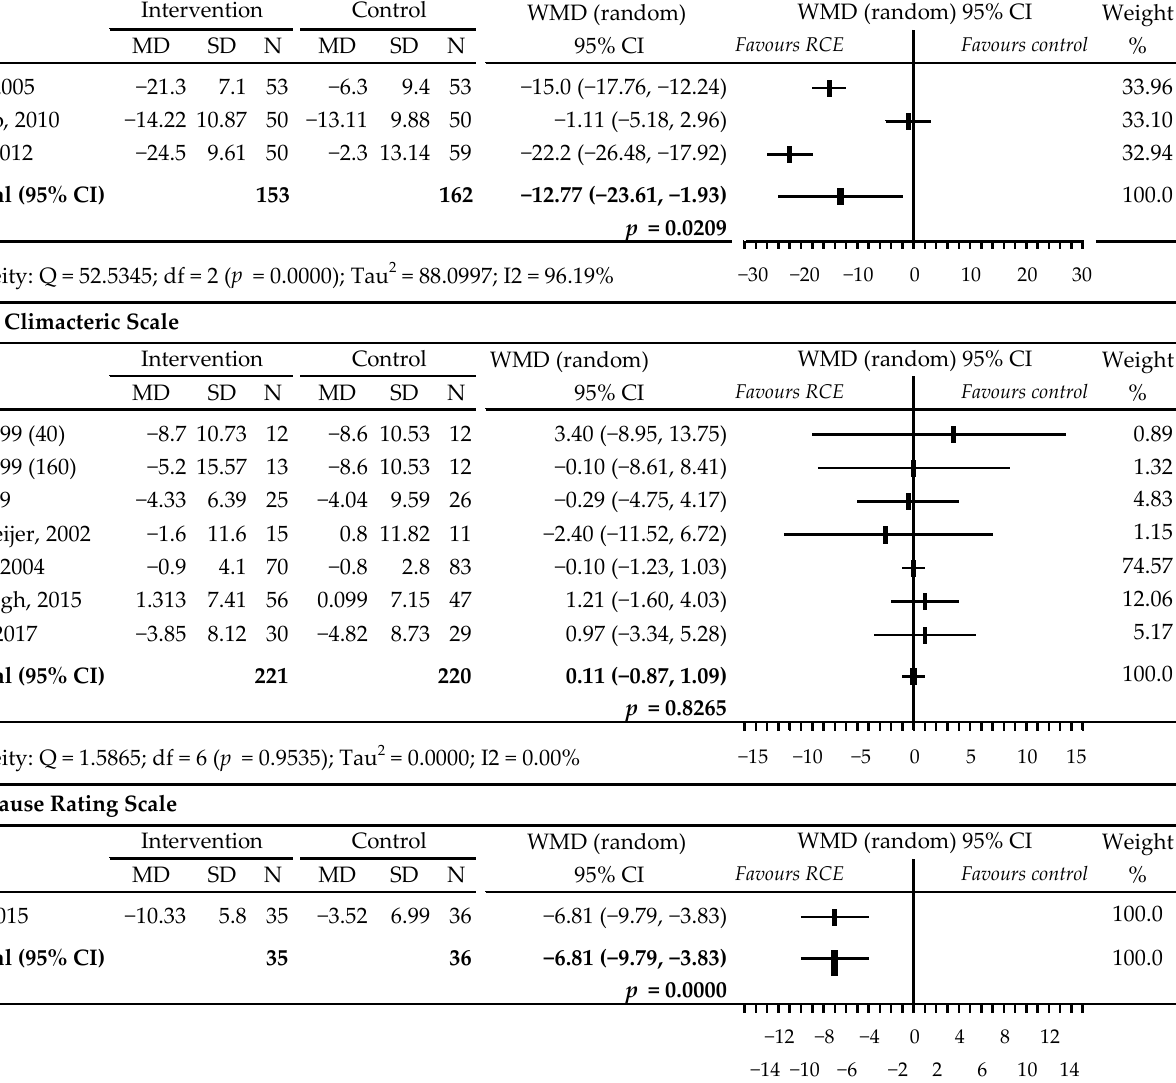
Figure 5. Effects of red clover ( Trifolium pratense ) isoflavones vs. placebo on rating menopausal symptoms using the following questionnaires, based on the respondents’ replies concerning the intensity of complaints. Number in brackets following author’s name refers to the dose of isoflavones in the study with more than one active group [33,34,36,38–44]. The letter A marks the first part of the figure containing the Kupperman Menopausal Index analysis. The letter B marks the second part of the figure containing the Greene Climacteric Scale analysis. The letter C marks the third part of the figure containing the Menopause Rating Scale analysis. Abbreviations: WMD, weighted mean difference.